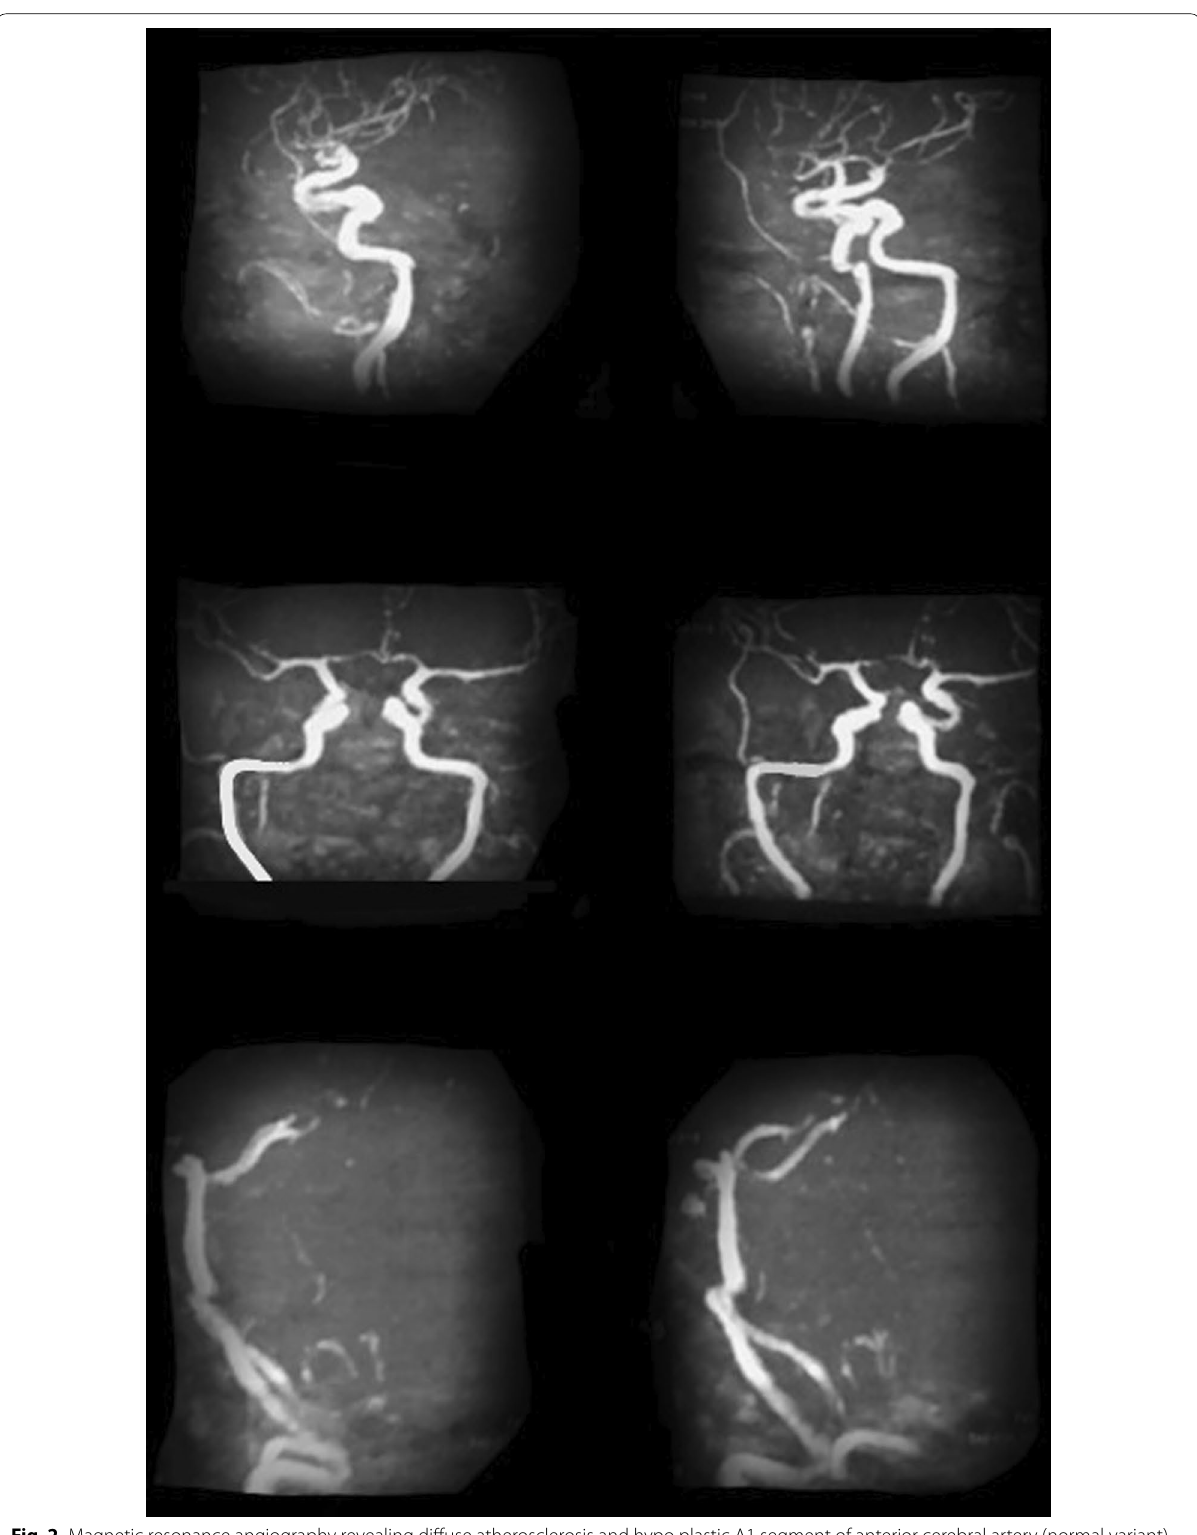
Fig. 2 Magnetic resonance angiography revealing diffuse atherosclerosis and hypo plastic A1 segment of anterior cerebral artery (normal variant) with no stenosis or hemodynamic